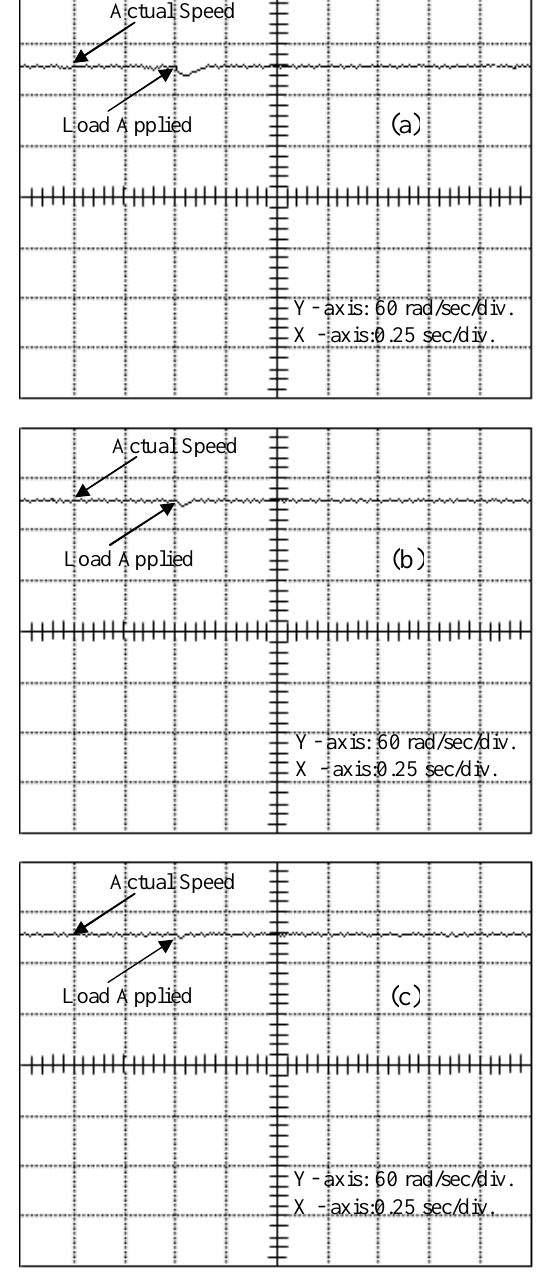
Fig. 16. Experimental results for sudden change in load for (a) PI controller b) Fuzzy PI controller and (c) the proposed Wavelet – fuzzy